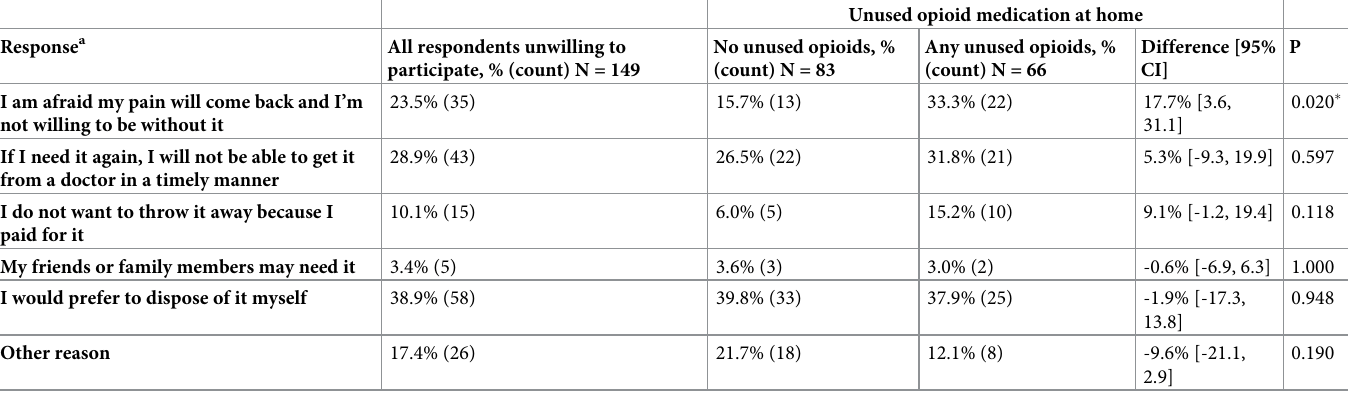
Unused opioid medication at